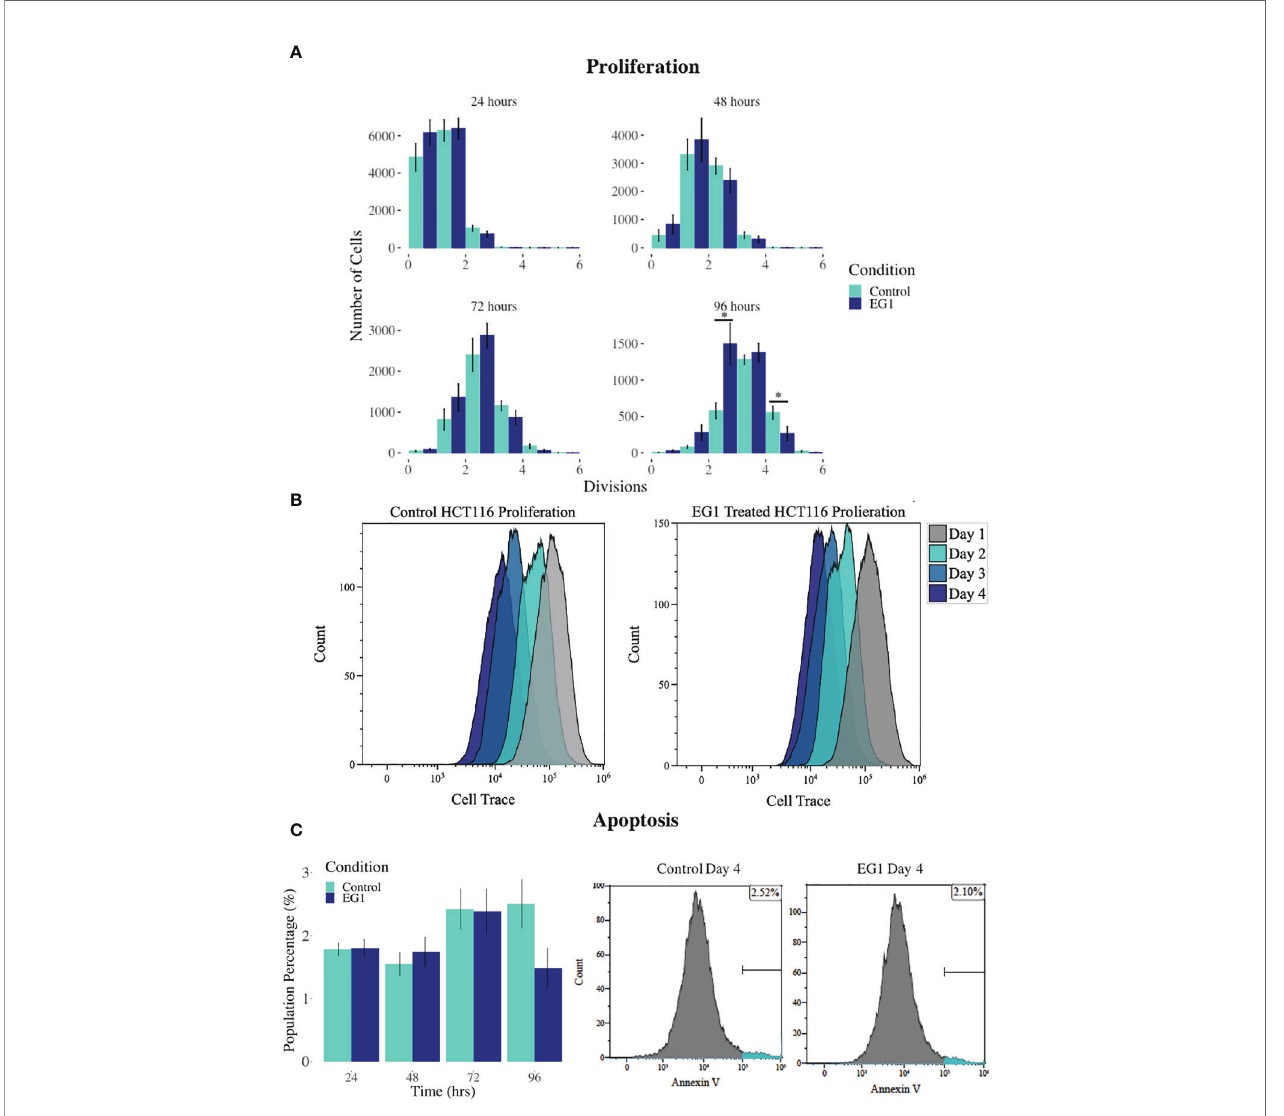
FIGURE 5 | Proliferation and apoptosis in 25 m mol/L EG1 treated and control HCT116 cell cultures. (A) A dye dilution fl ow cytometry assay was performed to determine proliferation in the HCT116 cultures at 24 hours, 48 hours, 72 hours and 96 hours. The population proportion per cellular division was calculated and plotted to show population distributions. At 96 hours the EG1 treated cultures (dark blue) had undergone signi fi cantly fewer divisions than the controls (light blue) (*p < 0.05, n=4). (B) Flow cytometry data of the dye dilution assay representing the loss of fl uorescence in the controls as they divided and retention of fl uorescence in the EG1 treated as proliferative events slowed over the 96 hours (n=4). (C) Apoptosis in the control and EG1 treated HCT116 cultures measured via fl ow cytometry showed no change in apoptosis over the 96 hours.